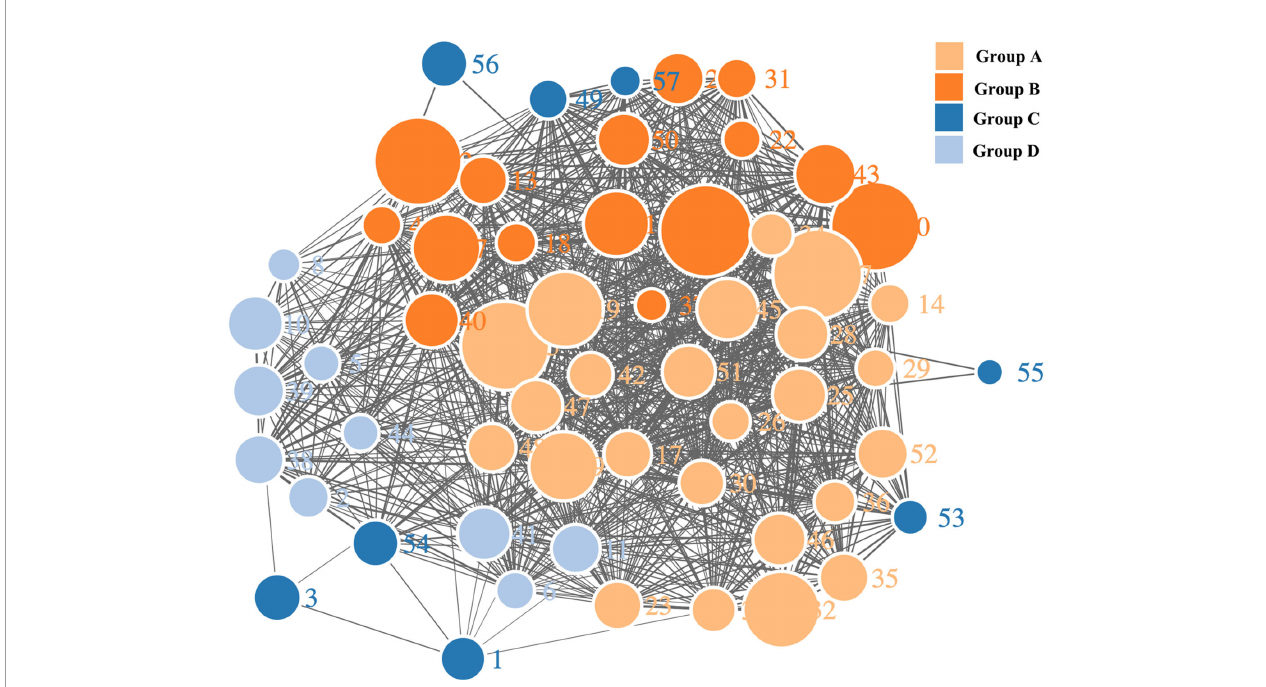
FIGURE 4 | Network diagram of the mass spectra of glycerides with software-based group classi fi cation.